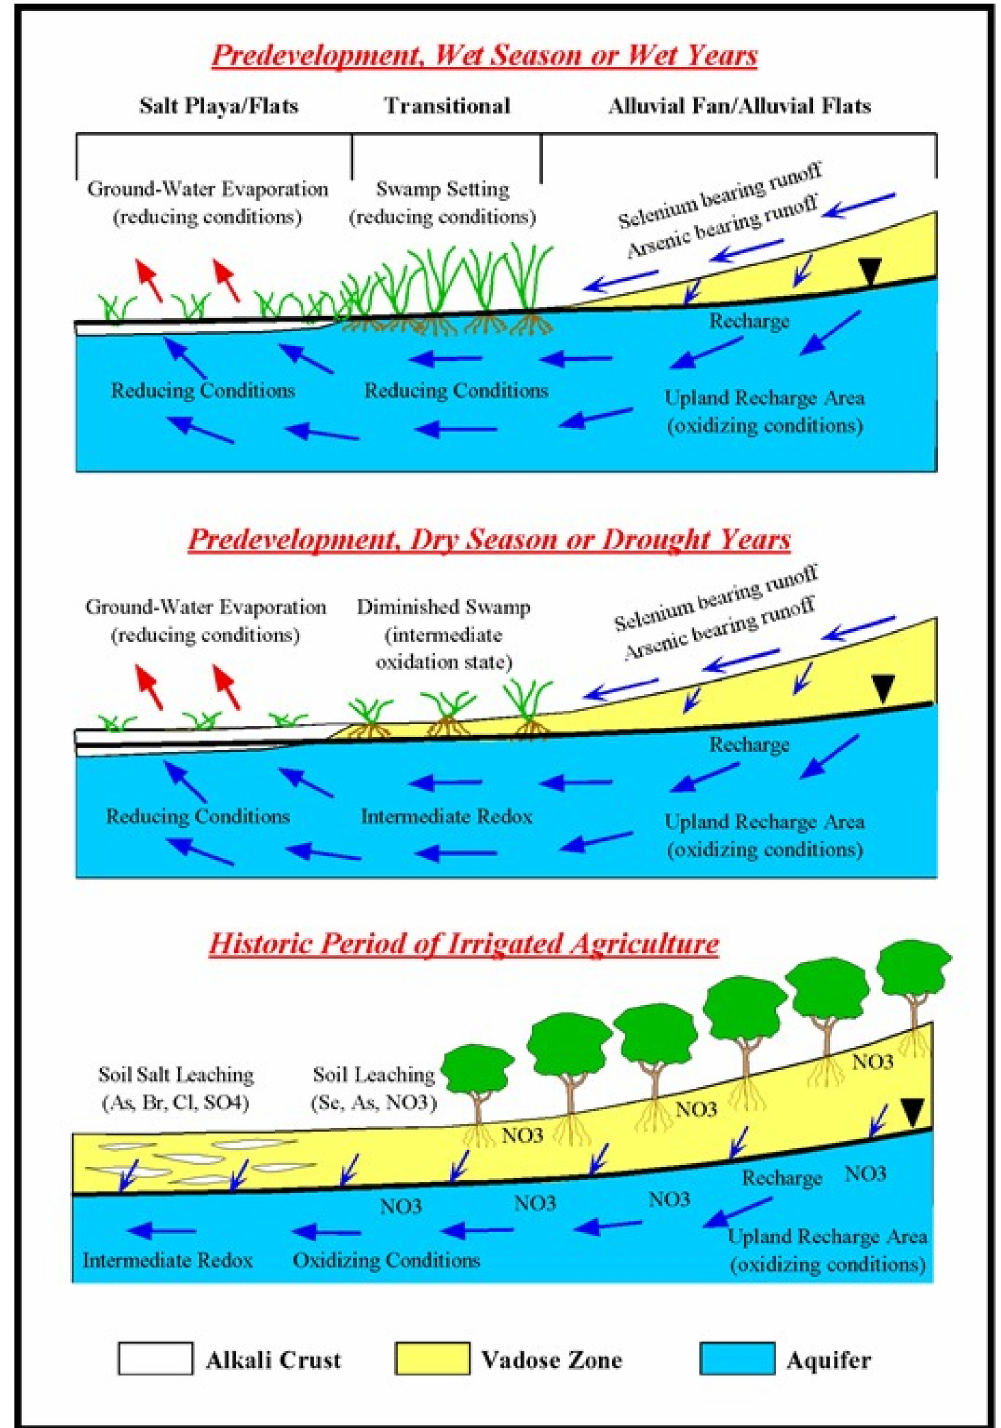
Figure 9. Time series conceptual models for water table and land surface conditions along a transect along Edinger Drain and Valencia Drain (Figure 8) showing conditions that are postulated to occur pre-and-post drainage of the marsh (swamp) and salt